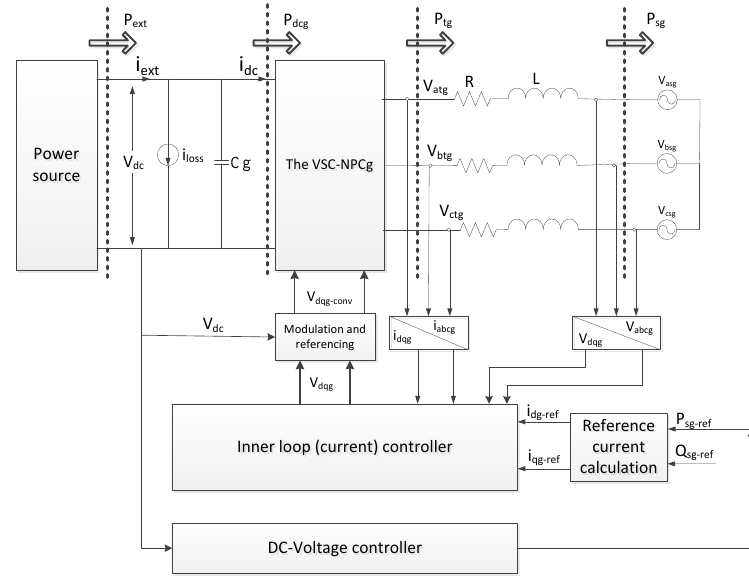
Figure 9. Simplified schematic diagram of the controlled DC-voltage power port of a three-level NPC-VSCg.